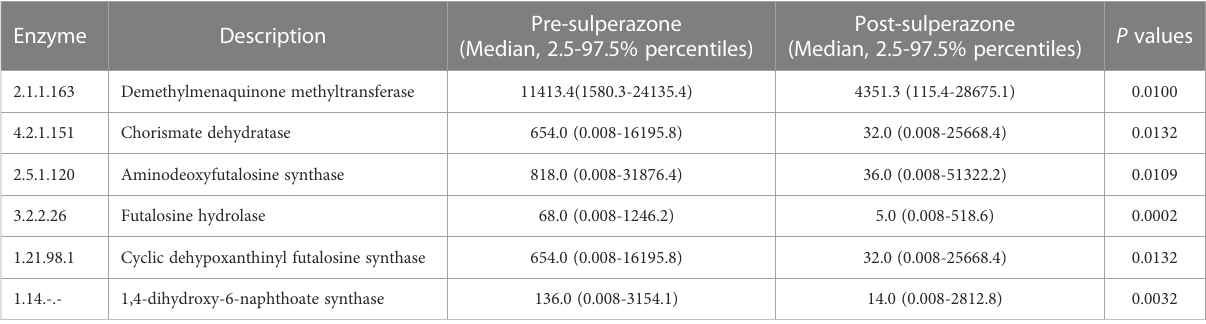
Pre-sulperazone Post-sulperazone (Median, 2.5-97.5% percentiles) (Median, 2.5-97.5%